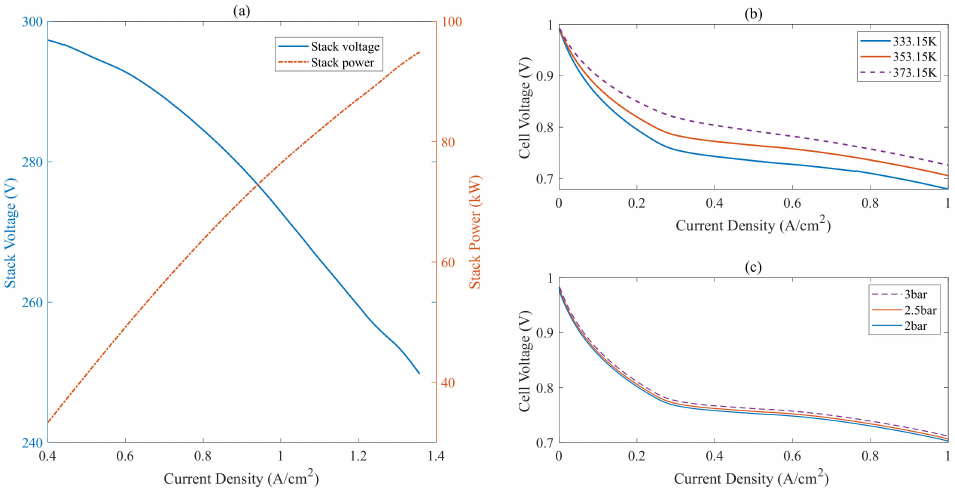
Figure 2. PEMFC model simulation and verification results: ( a ) Output characteristic curve; ( b ) Stack temperature; ( c ) Cathode pressure.